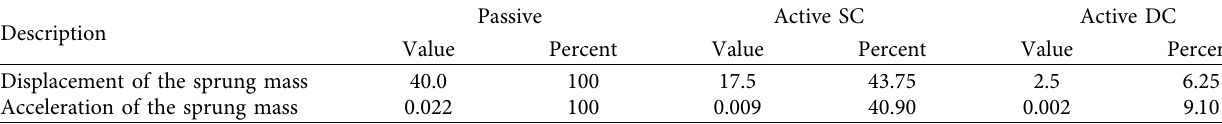
Table 3: The maximum value of case 1.